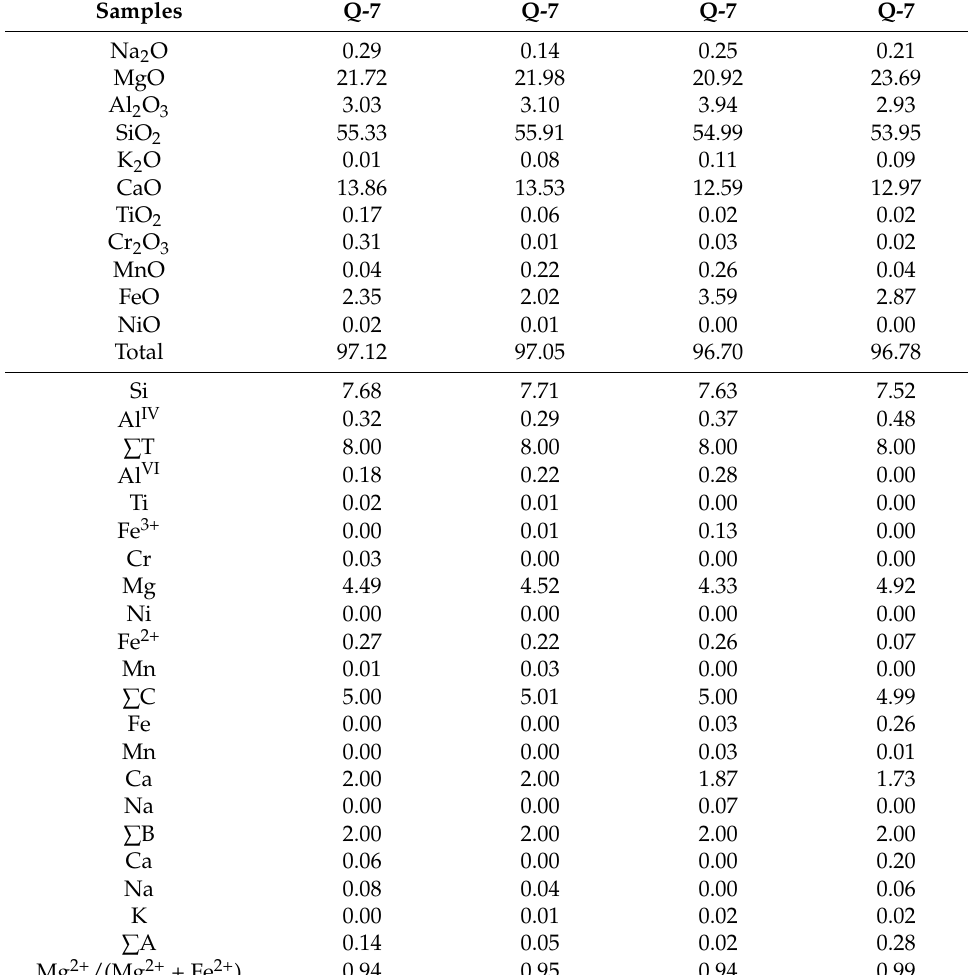
Table 5. Chemical compositions of the amphibole-supergroup mineral